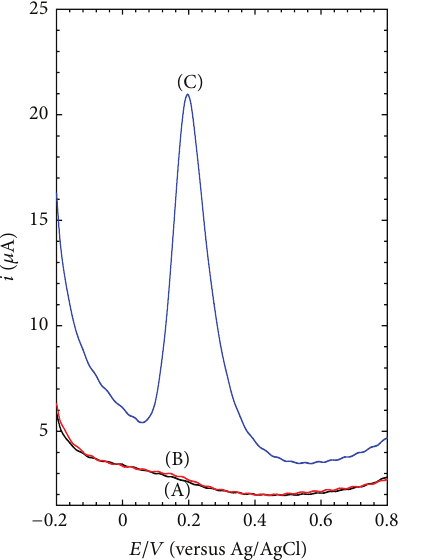
Figure 4: The square wave voltammograms obtained on the MCPE/ MNP in PBS, DA free, pH 7.0, and 0.1M NaClO 4 after 30min pre- concentration in PBS (pH 7.0) containing (B) 1.0 × 10 −3 M AA, (C) 5.0 × 10 −5 M DA. Curve (A) was obtained from blank solution. sonication was compared to the reported sonication route.